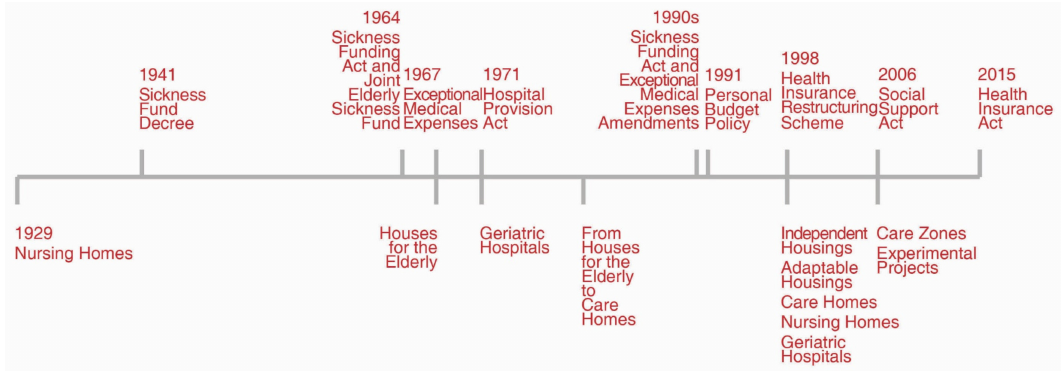
Figure 1 Architectural and care models timeline, c (cid:13) Davide